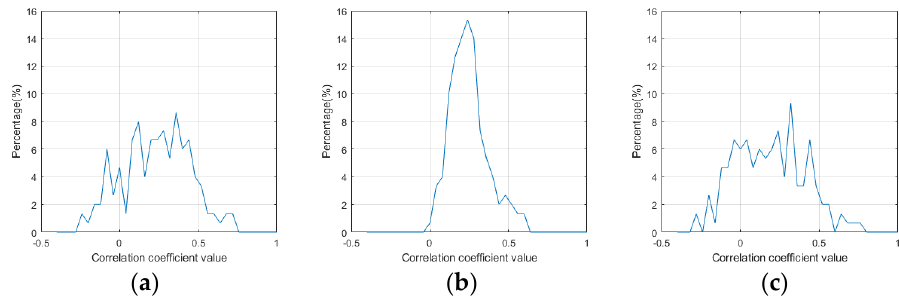
Figure 9. Histograms of the correlation coefficient of the whole image in three image sets. ( a ) Target images, ( b ) fake images using DCGAN, and ( c ) fake images using GA.